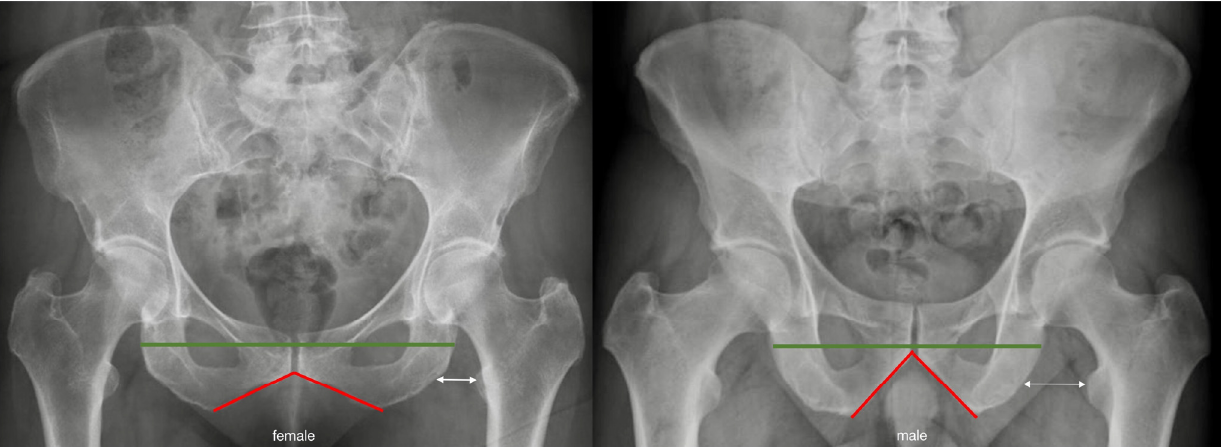
Figure 8. An example of a female pelvis on the left side and a male pelvis on the right. It is obvious that the increased pubic-arc angle (red) and corresponding widening of the interischial distance (green) results in a decrease in the ischiofemoral space (white), putting the female hip at a higher risk of ischiofemoral impingement.